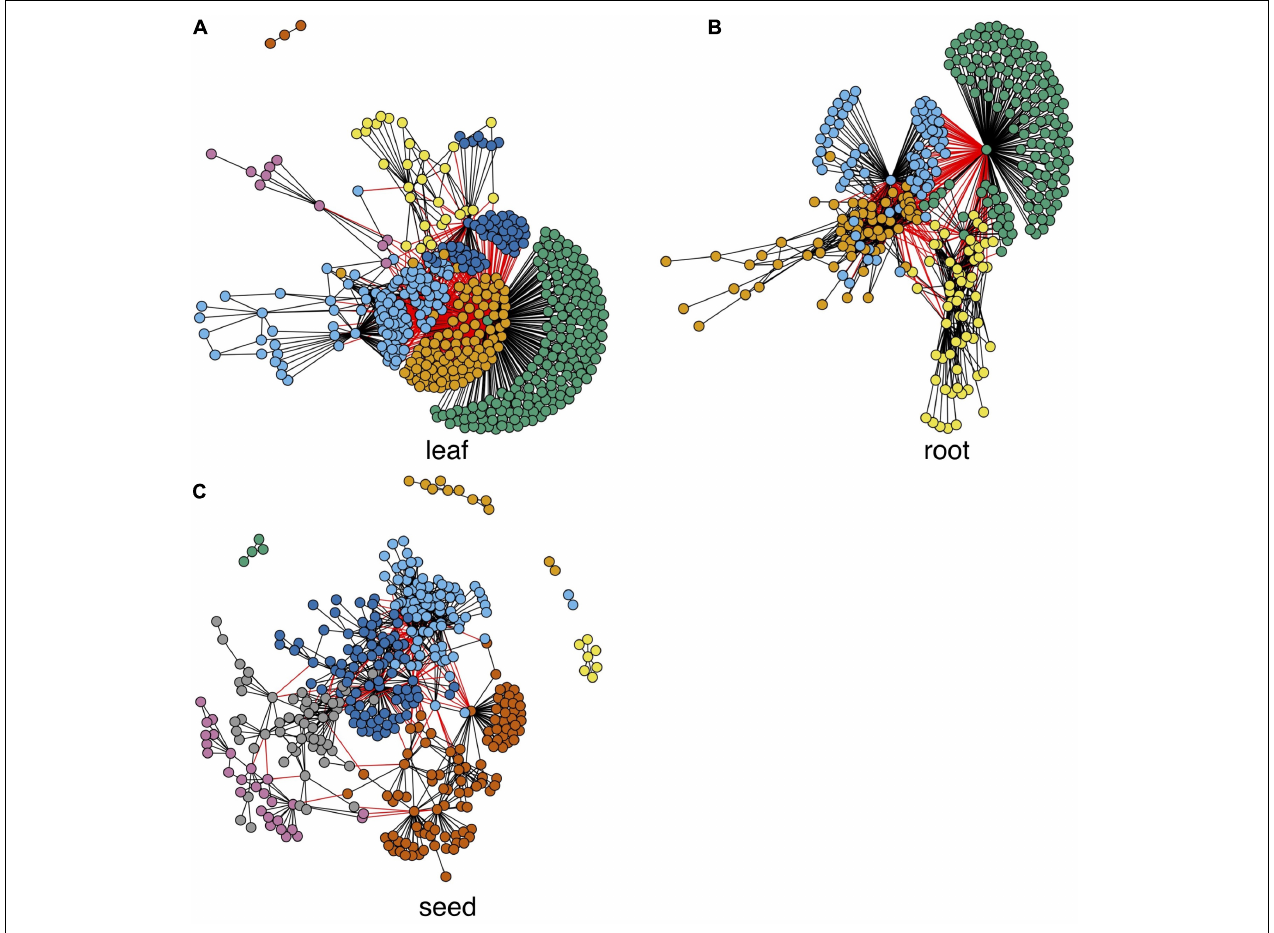
FIGURE 4 | Tissue-specific differential networks and their functional modules. Each node represents a gene, and each edge represents a differential edge. Modules are marked by nodes in different